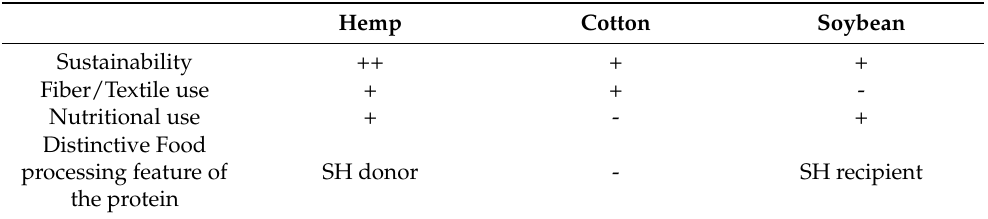
Figure 4. Examples of the industrial application of hemp ( a ), cotton ( b ), and soybean ( c ). Table 2. Comparative summary of hemp, cotton, and soybean in view of sustainability as a plant, as well as industrial applications.